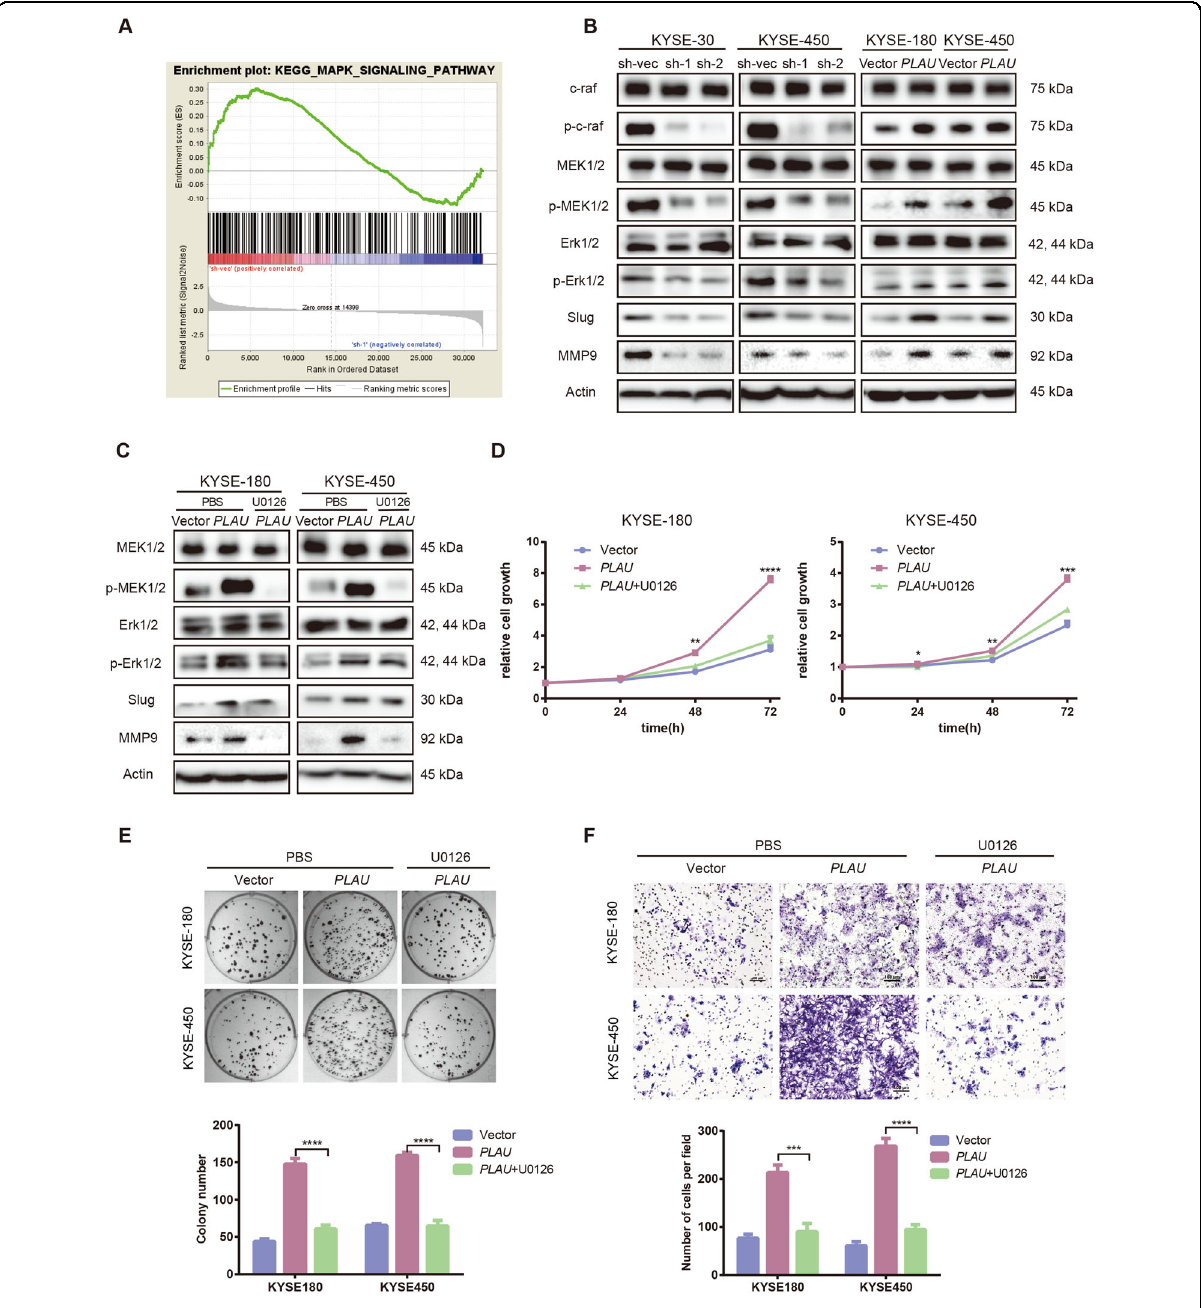
Fig. 4 PLAU promoted ESCC cell proliferation and migration via activation of the MAPK/MEK/Erk/Slug/MMP9 pathway. A MAPK signaling pathways enriched by sh-vec using GSEA. B , C Total and phosphorylated c-raf, MEK1/2, Erk1/2, Slug, and MMP9 expression levels in sh PLAU -1, sh PLAU - 2, and sh-vec KYSE-30 and KYSE-450 cells and overexpressing LAMC1 or vector KYSE-180 and KYSE-450 with ( B ) or without ( C ) U0126 treatment, a highly selective inhibitor of MEK1/2. D – F Proliferation, colony formation and migration of KYSE-180 and KYSE-450 cells overexpressing PLAU and vector with or without U0126 treatment. The number of colonies or migrating cells were compared between the groups (the bottom panel). Three biological replicates were performed for in vitro assays. Data in bar charts are presented as the mean ± SD. * P < 0.05, ** P < 0.01, *** P < 0.001, **** P < 0.0001 (Student ’ s t